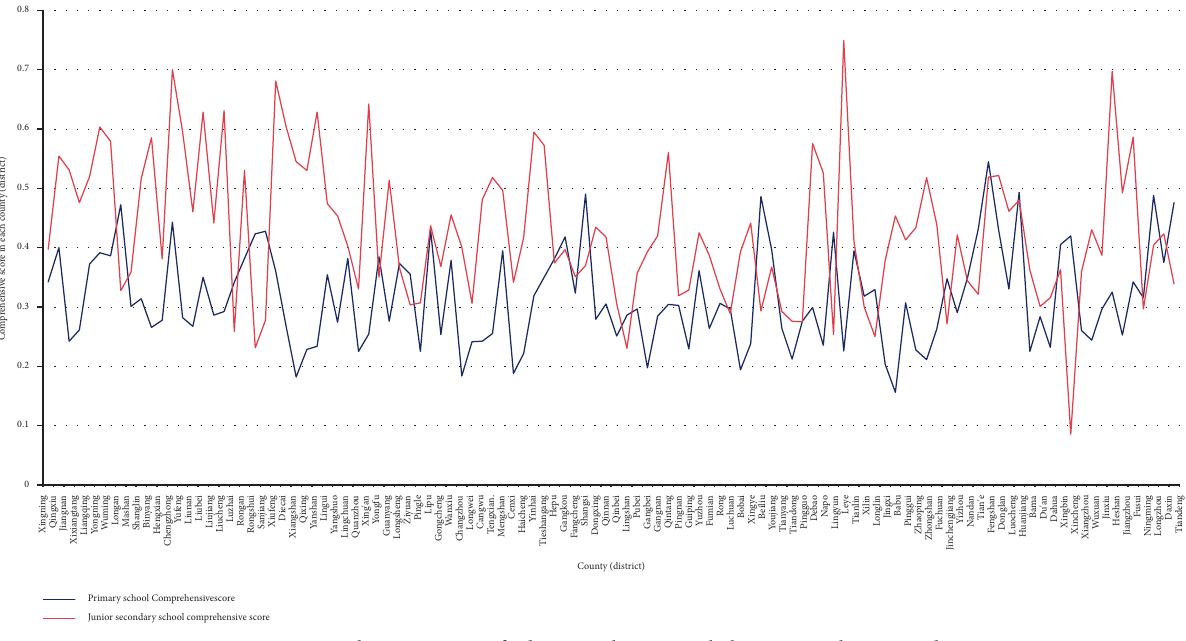
Figure 3: Comprehensive score of educational resource balance in each county/district.